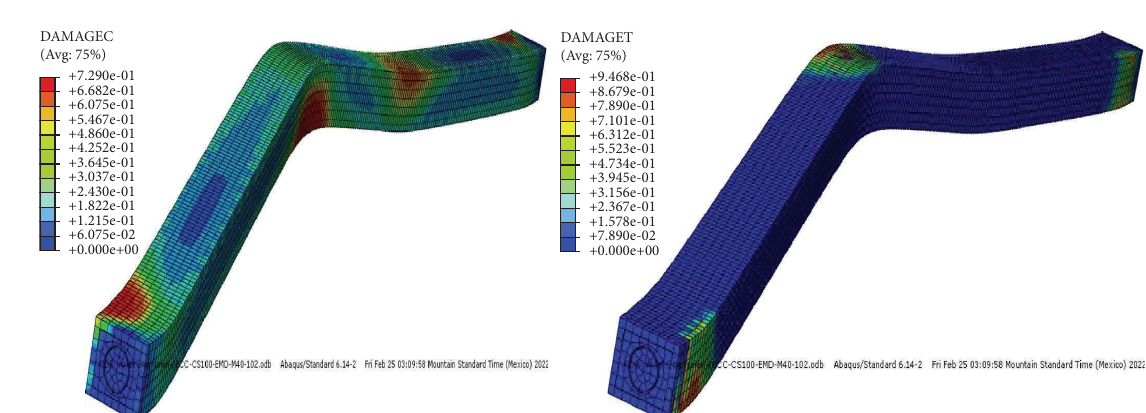
Figure 11: Stress components and crack pattern of concrete in compression and